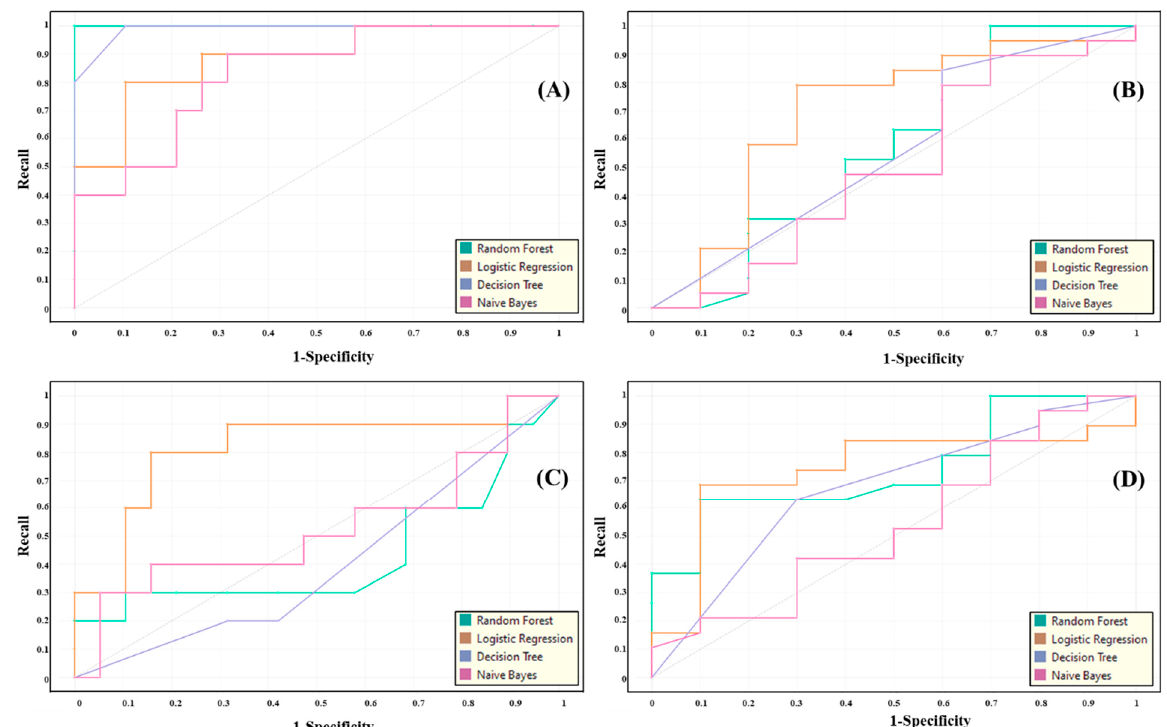
Figure 8. ROC curves of the intra-subject (mental stress and normal) classification with models such as ( A ) leave one out, ( B ) 10-fold, ( C ) 3-fold, and ( D ) 2-fold on thirteen features, including demographic and extracted through ECG signal. Table 3. Performance of the intra-subject (mental stress and normal) classification using thirteen features, including AHR, MRR, seven HRV, and four demographic features.